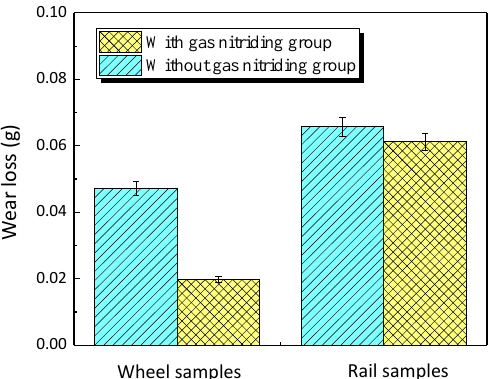
Figure 9. Comparison of wear loss for the wheel and rail specimens with and without gas nitriding groups: N = 2 × 10 5.